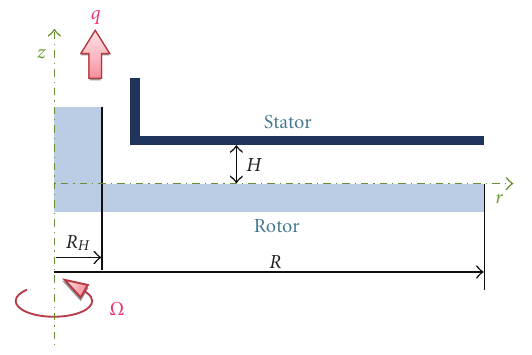
Figure 1: Schema of the rotor-stator